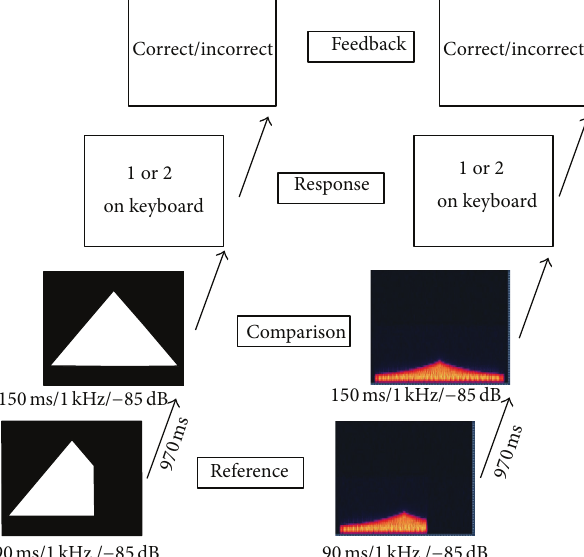
Figure 2: Representation of a sample trial. Listeners are presented with a reference soundscape followed by a 970 ms interstimulus gap. They are then presented with a comparison tone and are required to indicate whether the reference tone was presented 1st or 2nd. In the standardcondition thereference toneisalways of thesameduration, with reference and comparison tones presented in a random order. Feedback is given after the response before the onset of the next trial. The duration of the reference tone is stable with the comparison tone adapted on a 3 up/1 down staircase procedure. The left hand column of the figure shows the image that was sonified, with the right hand column showing the spectrogram for the resultant soundscape.